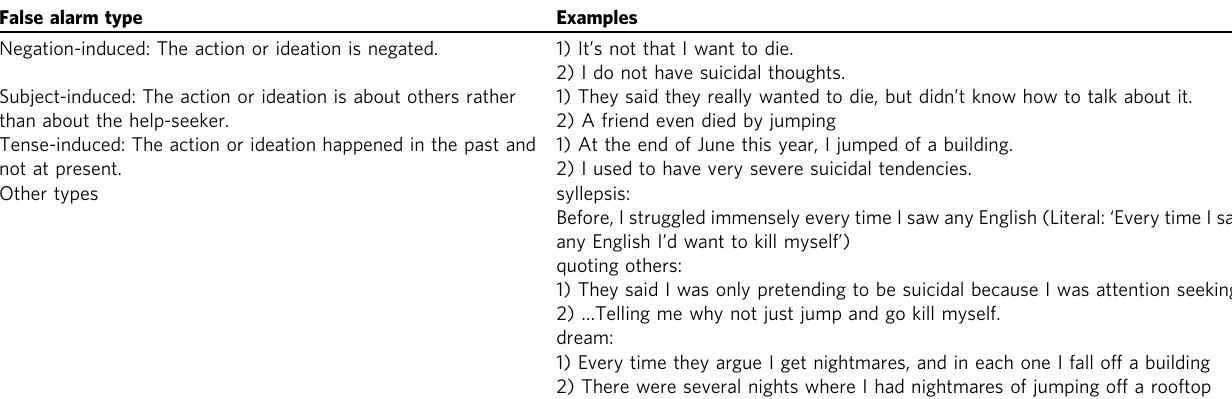
Table 1 Typical false alarms when relying on keywords matching